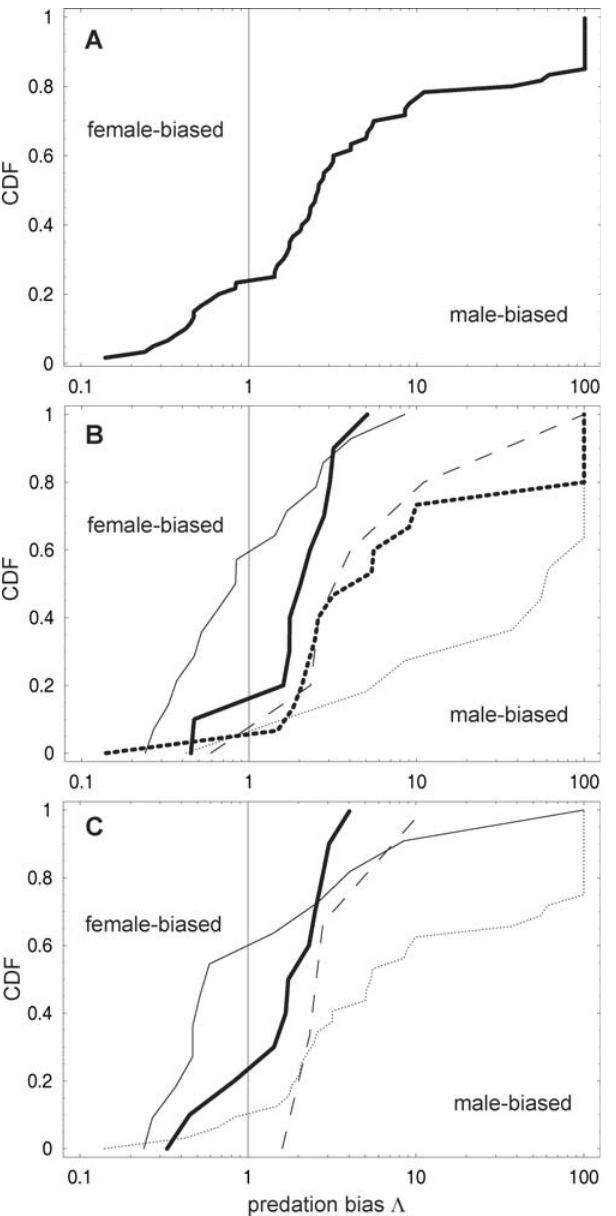
Figure 2. Cumulative distribution function (CDF) of empirical data on sex-biased predation. L =ratio of male/female prey eaten weighed by the prey sex ratio; large values truncated at L =100. CDF( z )=fraction of predator-prey pairs with L # z . A. All predator-prey Figure 3. Illustration of population dynamics and the stabiliz- pairs with significant results and at least 10 prey items ( n =60). B. ing and destabilizing effect of sex-selective predation in model Predator-prey pairs grouped over different predator taxa: thin dotted (4). A. Two types of dynamics for unlimited polygyny and no Allee line=insects ( n =12); thick dashed line=arachnidans ( n =16); thin effect. Male-biased predation leads to a stable predator-prey equilib- dashed line=molluscs, fishes and reptiles ( n =6); thin solid line=birds rium E 2 (thin dashed curve; L =2); female-biased predation leads to ( n =15); thick solid line=mammals ( n =11). C. Predator-prey pairs increasing oscillations prone to collapse (thick curve; L =0.5). Other grouped over different prey taxa: thin dotted line=insects ( n =33); thin parameters: b =3, d =0.2, H =0, e 1 =0.2, e 2 =0.1, M =1. Initial conditions: solid line=crustaceans ( n =12); thin dashed line=fishes and amphib- m = f =4, x =1.5. B. Stabilizing effect of the male-biased predation, ians ( n =4); thick solid line=birds and mammals ( n =11). shown in the per-capita population growth rate of the total prey doi:10.1371/journal.pone.0002687.g002 population as a function of total prey density, m + f ; data were generated by computing trajectories for ten random initial conditions and systems, we plot the per-capita growth rate of the entire prey selecting points with predator density close to equilibrium, x , x * d m z f ð Þ population, 1 , as a function of the total prey population m z f d t (results for other fixed predator densities were similar). L =2, other density m + f (Fig. 3B and C). This illustration is not relevant for parameters as in A. C. Destabilizing effect of the female-biased specialized predators that feed only on male or female prey (see predation, shown as in B. L =0.5, other parameters as in A. Text S2 for analysis). Male-biased predation of polygynous prey